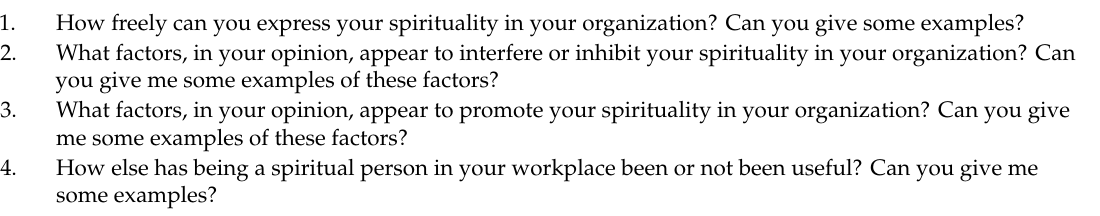
Table 1. Interview questions about integrating Christian SAW from McGhee (2015, p.